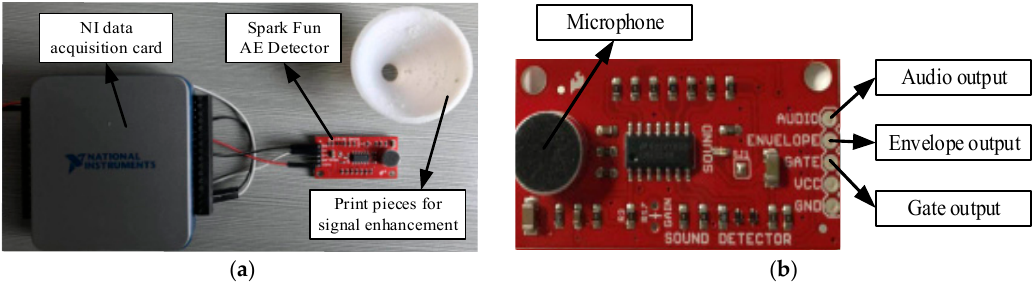
Figure 2. ( a ) The AE signal acquisition system, where ( b ) is the AE detector used for AE signal collection, the NI data acquisition card is used to send the data to computer and the printed piece is used for signal enhancement.